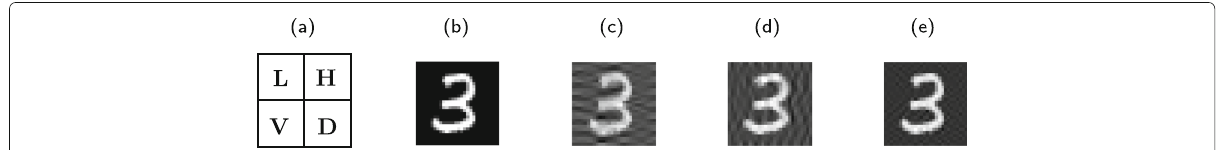
Fig. 8 Local key-based sign flipping in the DCT sub-bands: a sub-bands, b original image, c image with a sign flipping in V sub-band, d image with a sign flipping in H sub-band, and e image with a sign flipping in D